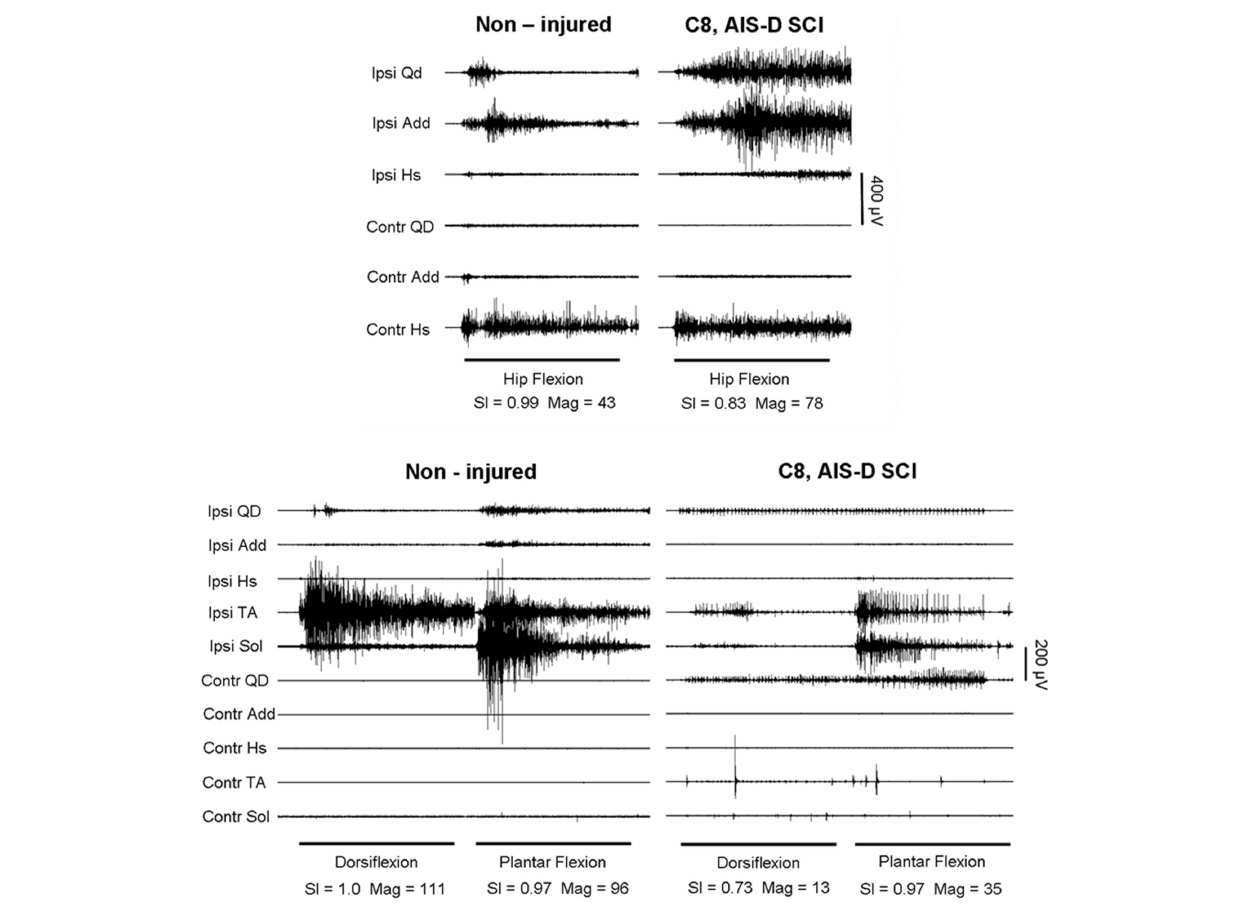
FIGURE 2 | Hip and knee flexion (top), ankle dorsiflexion and plantar flexion (bottom), in a non-injured subject and a person with motor-incomplete SCI (Subject #3) . Muscles shown are Ipsilateral (Ipsi) and contralateral (Contr) quadriceps (Qd), adductor (Add), hamstring (Hs), tibialis anterior (TA), and soleus (Sol).